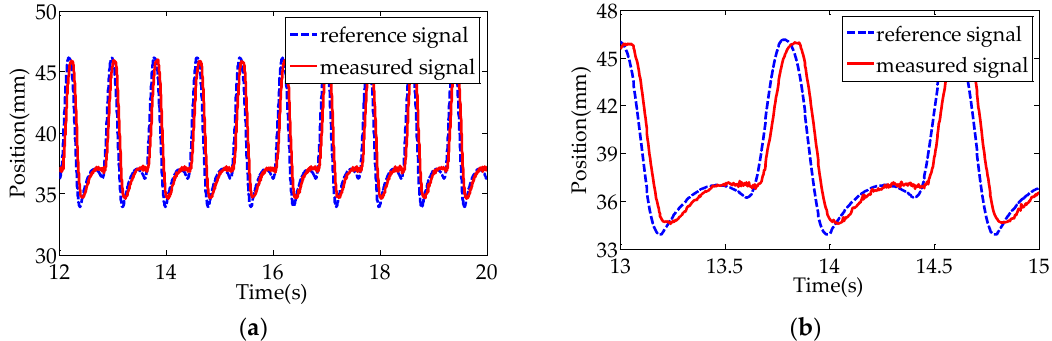
Figure 15. The pitching knee joint position tracking curves of RF leg of the robot. ( a ) Response curves; ( b ) Local amplification curves.